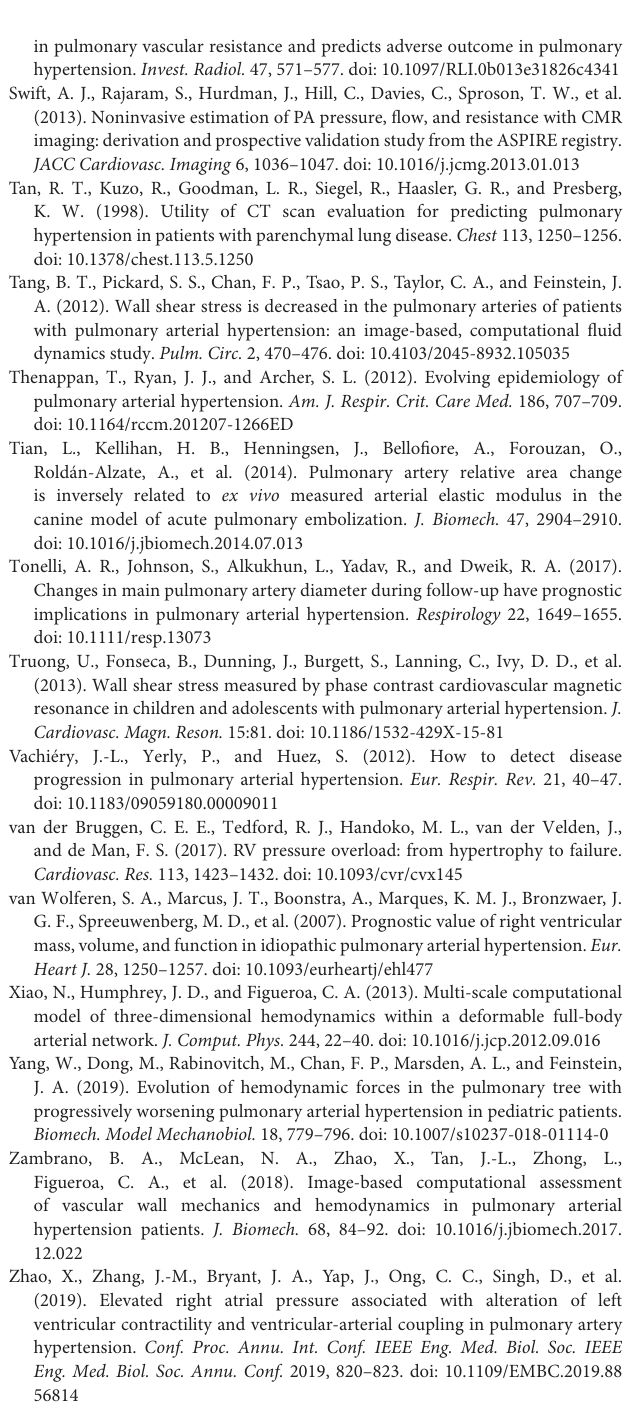
Conflict of Interest: The authors declare that the research was conducted in the absence of any commercial or financial relationships that could be construed as a potential conflict of